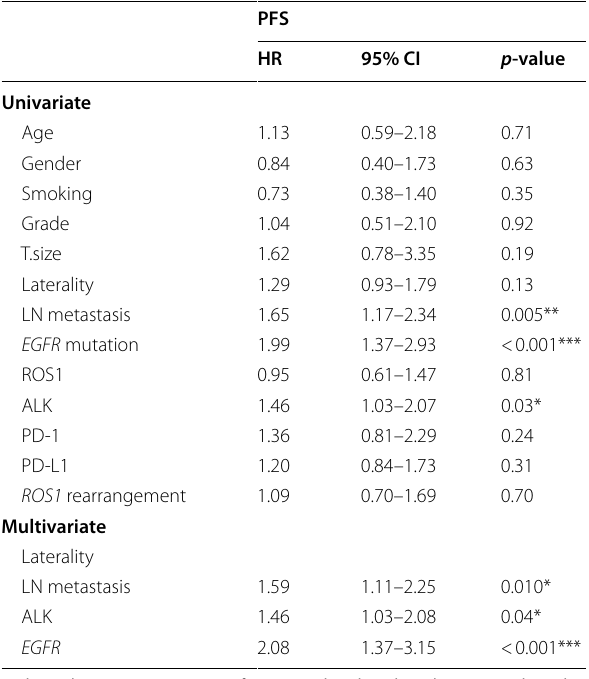
Table 4 Univariate and multivariate survival analysis for NSCLC